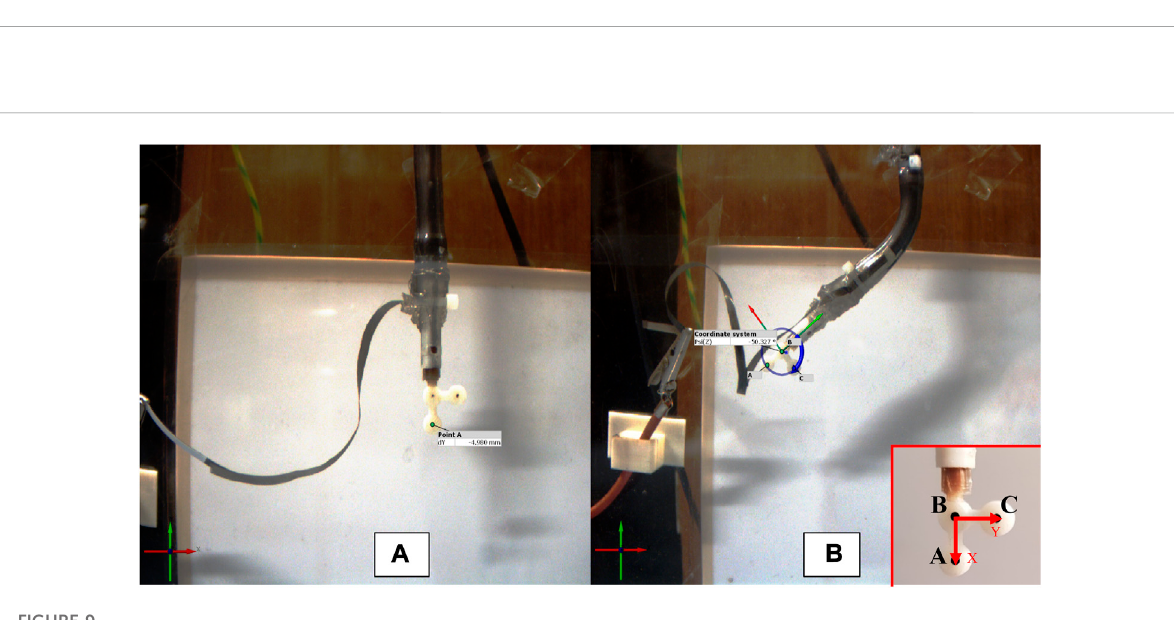
FIGURE 8 Fabrication procedure of the spring-roll DE actuator: (A) Pre-stretch of the DE; (B) Coating of the compliant electrode for linear-type DE actuator; (C) Coating of the compliant electrode for bending DE actuator; (D) Spring core accommodated in the beginning slot before rolling; (E) Rolling the spring core along the frame and wrapping DE fi lms on it; (F) Fabricated sample beside a one penny coin.